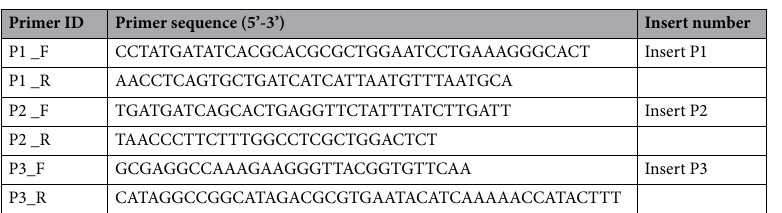
Table 3. Oligonucleotide primer sequences for PCR amplification of the PTPRG 3 ′ -UTR.